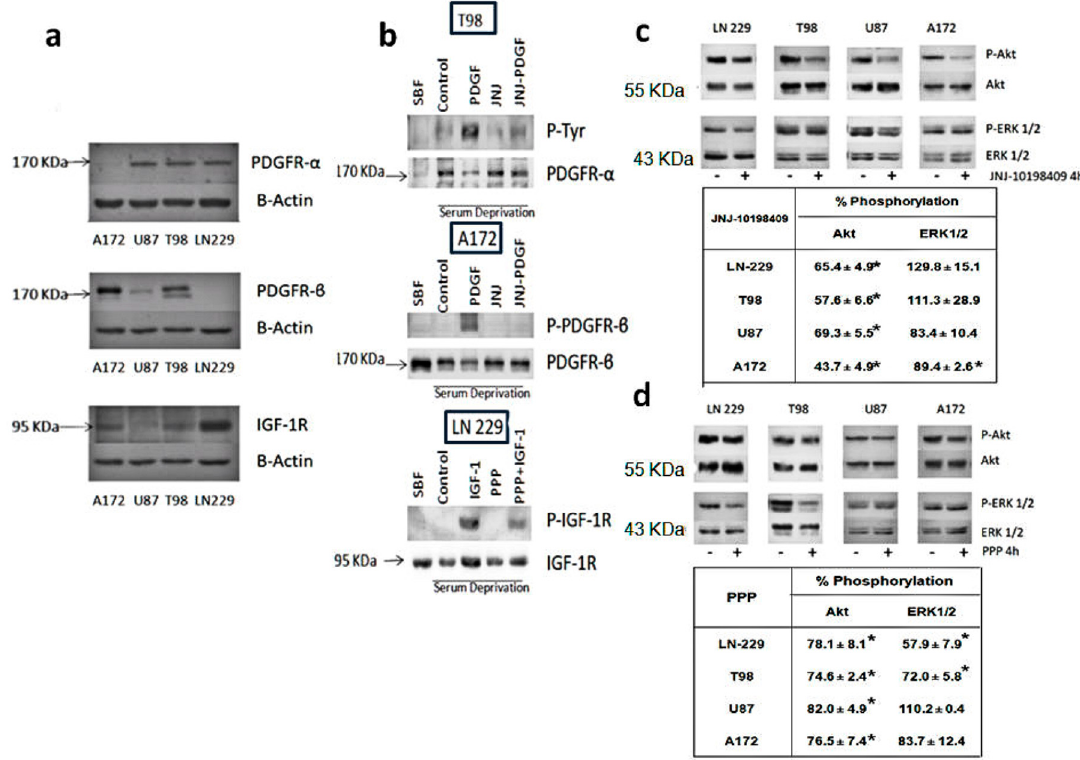
Figure 1. Expression, activation and downstream signaling of PDGFR and IGF-1R. ( a ) PDGFR and IGF-1R expression levels. PDGFR- α , PDGFR- β and IGF-1R levels in GBM cell lines were analyzed by Western blot. β -actin was used as an internal control. ( b ) PDGFR and IGF-1R phosphorylation levels. T98 or A172 cells were grown in 10% FBS-containing media (FBS) and serum-starved for 24 h. Then,